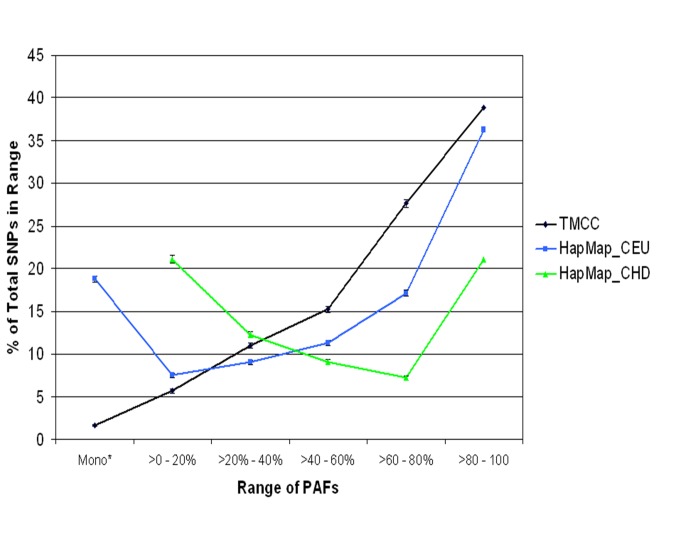
The proportion of PAFs in ranges for TMCC and HapMap populations.